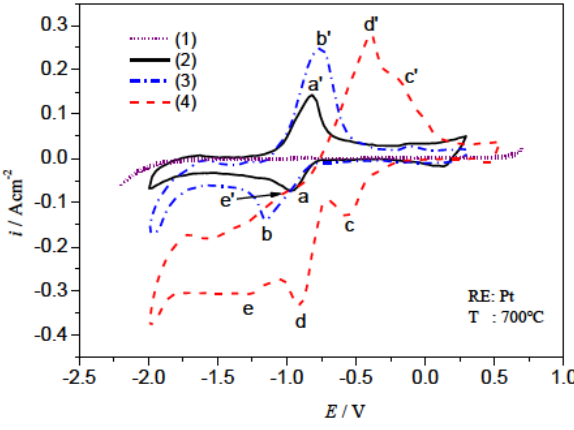
Figure 3: Typical cyclic voltammogram curves in NaCl-KCl-NaF melt (scan rate: 300 mV/s)